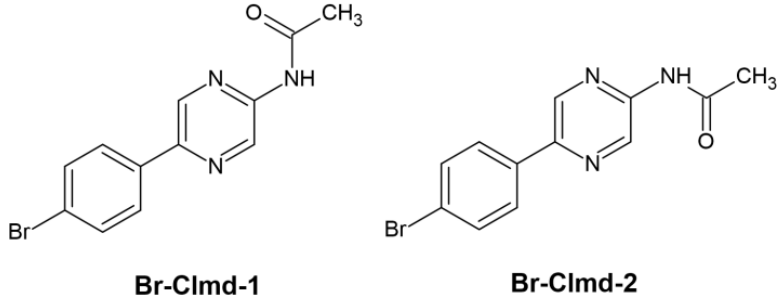
Figure 6. Possible conformations for Br-Clmd.